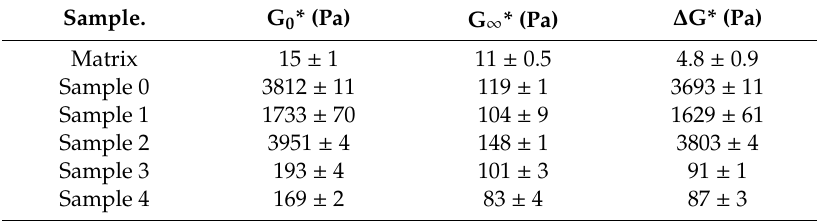
Table 3. The complex moduli, G 0 * (at very low strain) and G ∞ * (at high strain), and Payne amplitude ( ∆ G*) values for the tested polymer matrix and samples.